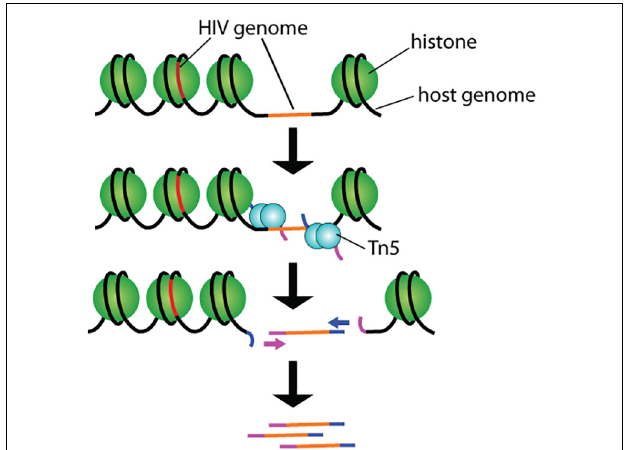
FIGURE 3 | Schematic representation of the ATAC-seq technology. Tn5 transposases preloaded with DNA adapters fragment and tag accessible genomic DNA. Resulting fragments are sequenced and correlated with open and closed chromatin for epigenomic profiling.